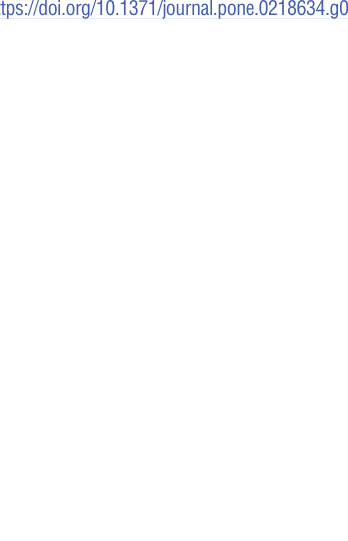
Fig 3. Forest plot with odds ratios and 95% confidence intervals of factors associated with 1-year-survival after propensity score-matched analysis.